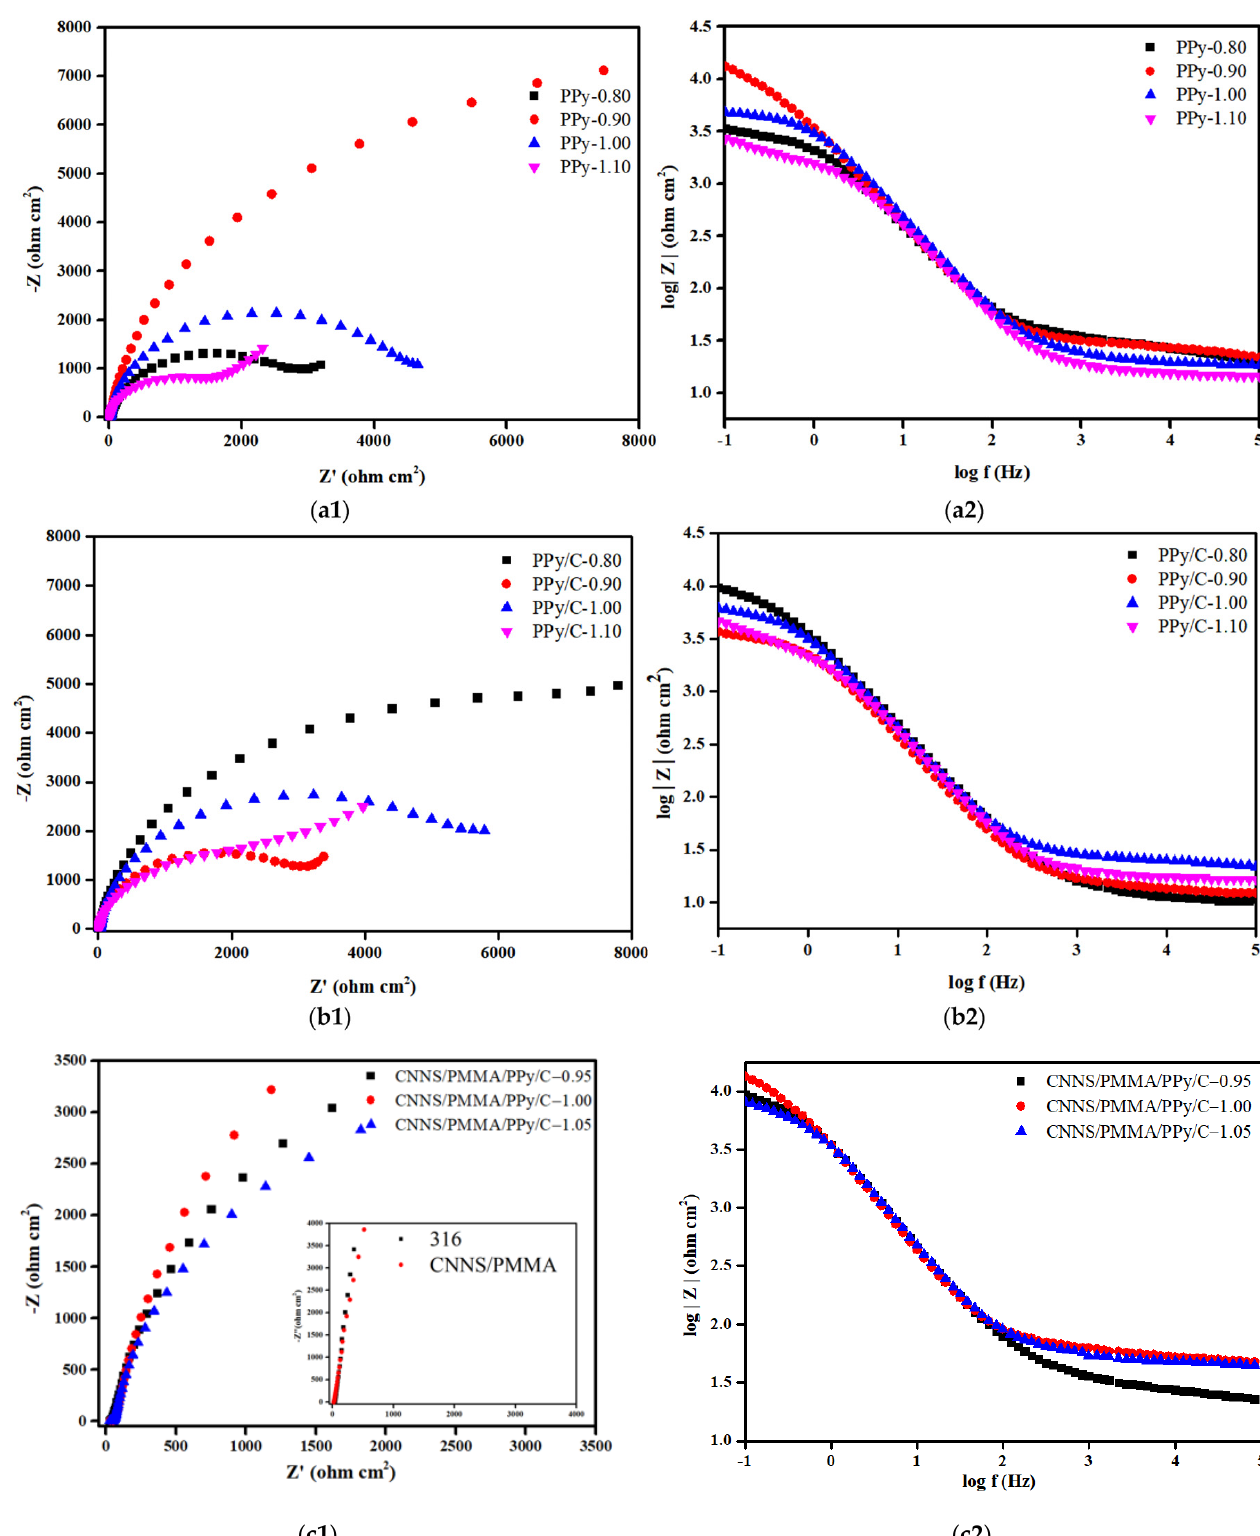
Figure 3. The Nyquist and Bode plots of: ( a ) pPy, ( b ) pPy/c, and ( c ) CNNS/PMMA/pPy/C. Figure 3 shows the Nyquist plots and Bode plots of the sample in the simulated PEMFC working environment, and the experimental data were fi tt ed by the equivalent circuit diagram. The derived fi tt ing parameters are summarized in Table S1. In the equiv- alent circuit diagram, Rs is the resistance of the solution, and CPE1 and Rcoat are related to the composite/electrolyte interface, where Rcoat represents the micropore resistance on the surface of the fi lm material and CPE1 is the capacitance of the simulated coating ma- terial. CPE2 and Rct are related to the charge transfer reaction caused by electrolyte per- meation. CPE2 is an electrical double-layer capacitance that simulates the bubble part of the interface, and Rct is a tt ributed to the charge transfer resistance of the base metal cor- rosion reaction. The Rct in the fi tt ing parameters is inversely proportional to the corrosion rate of the sample, indicating the corrosion rate. It can be seen from the fi tt ing results that the fl uctuation of Rs is small, indicating that the testing system is in a relatively stable state. Di ff erent from 316SS, the Nyquist plots of anti-corrosion coating consists of a capac- itive arc with a large radius of curvature. Usually, the radius of capacitive arc re fl ects the size of charge transfer resistance during electrochemical corrosion, and the larger the ra- dius of capacitive arc, the greater the charge transfer resistance and the be tt er the corrosion resistance of the material. Analysis of the Bode plots showed that the coating has two time constants, one is the capacitor of the coating itself, and the other is the double-layer capac- itor of the metal surface, indicating that the corrosion e ff ect makes the coating change. pPy-0.90, pPy/C-0.80, and CNNS/PMMA/pPy/C-1.00 showed the largest |Z| values in the low-frequency region, with their maximum phase angles corresponding to the lowest fre- quency, where CNNS/PMMA/pPy/C-1.00 showed optimal corrosion resistance. In the fre- quency range from 1 to 100 Hz, a linear relationship was observed between the impedance and frequency, with a slope close to one. Nyquist plots shows a small capacitance loop at high frequency, which indicates that the coating has relatively high conductivity at the beginning, so the surface of 316SS is in a passive state. Generally speaking, a high-frequency capacitive arc re fl ects the electro- lyte/coating interface, while a low-frequency capacitive ring indicates the response of elec- trochemical process at the coating/316SS interface. According to Nyquist plots, the CNNS/PMMA/pPy/C-1.00 coating-synthesized constant voltage has the largest capaci- tance loop, which indicates that the coating has the largest resistance (Rct), the best me- chanical isolation performance and great corrosion resistance. The increase tendency in the low-frequency region for samples mean that weak Warburg di ff usion starts to appear, indicating that the metal has been corroded under the coating, the corrosion product fi lm begins to a ff ect the electrochemical reaction, and the coating has limited protection of the